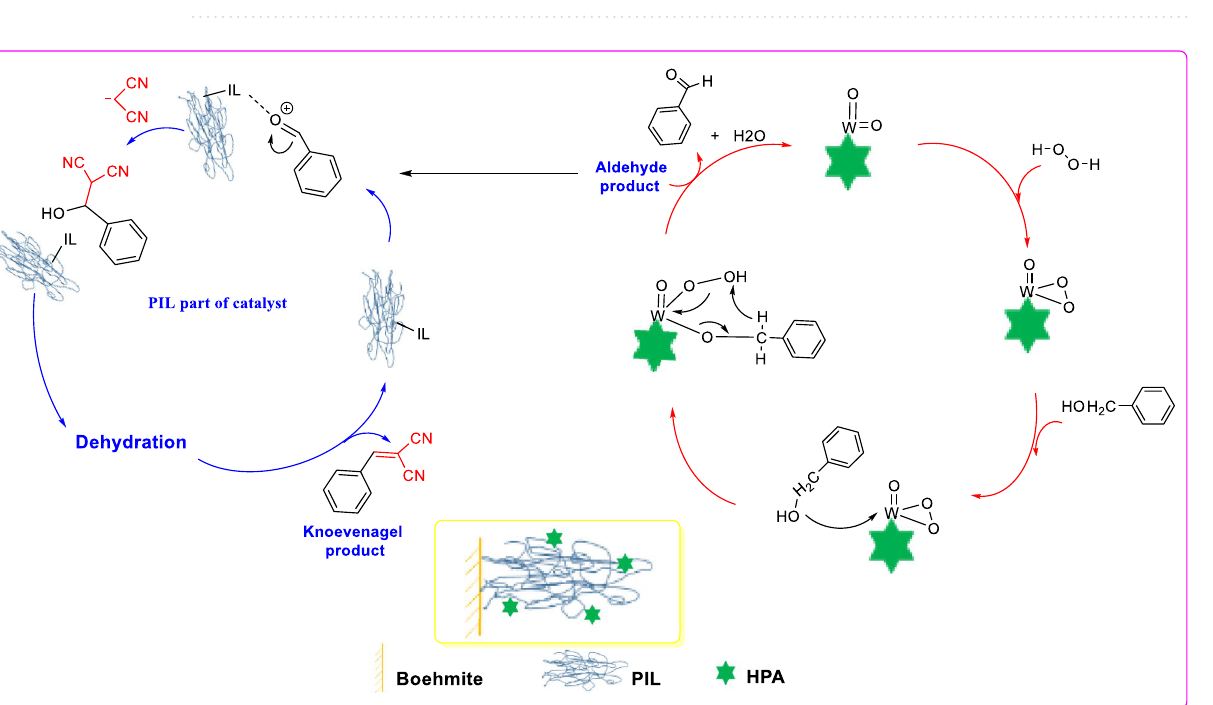
Table 5. Comparison of the activity of B-V-PIL/W for one-pot tandem alcohol oxidation/ Knoevenagel condensation reaction with some reported catalysts. a Ni ‐ based metal–organic framework. b H 6 TATAT = 5,5,5-(1,3,5-Triazine-2,4,6 triyl)tris(azanediyl)triisophtalate. magnetic Poly(Bis-imidazolium ionic liquid). d Oxidation step at 90 °C (4 h) + Knoevenagel condensation step at room temperature (2 h).